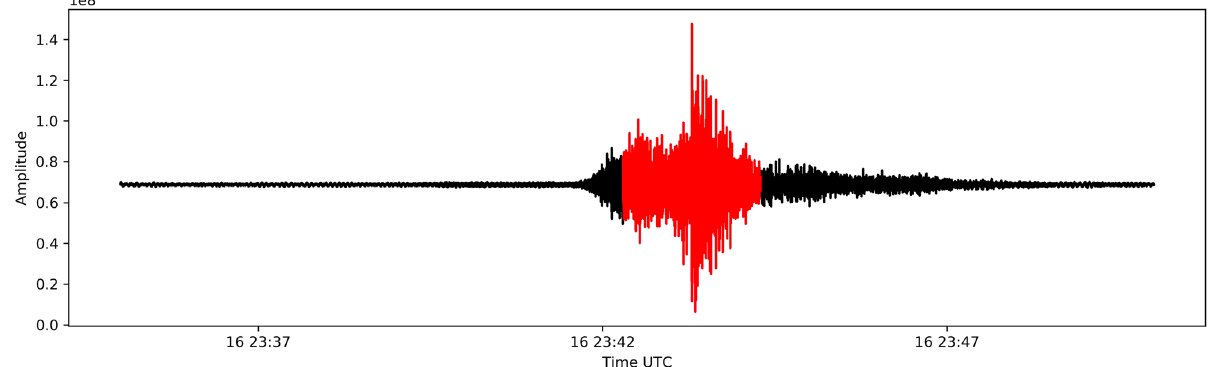
Figure 4. Signal related to the studied tectonic event recorded by the ‘H11N1’ hydrophone. In red highlighted relevant acoustic